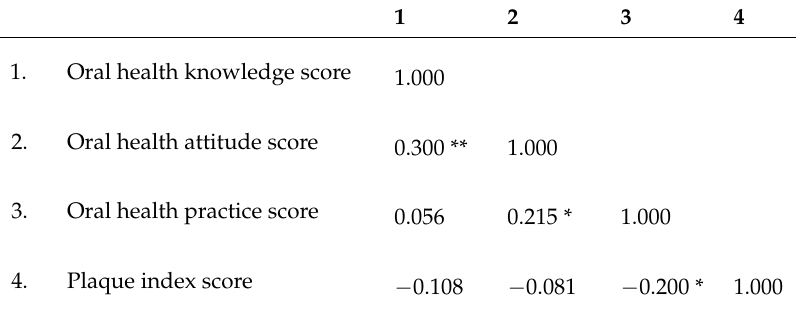
Table 4. Correlations among oral health determinant factors (N =